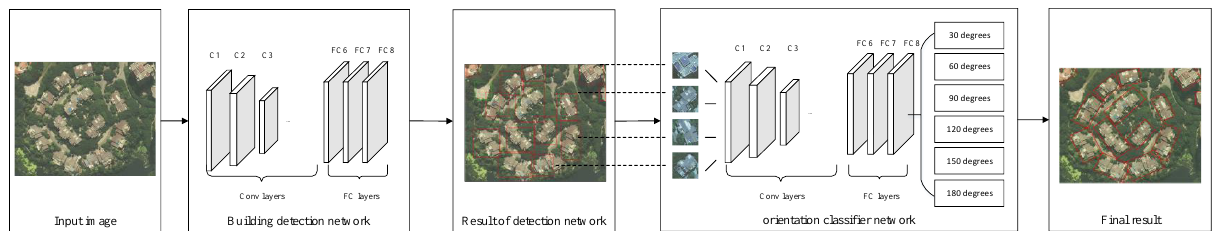
Figure 1. Overall framework of the proposed building detection system